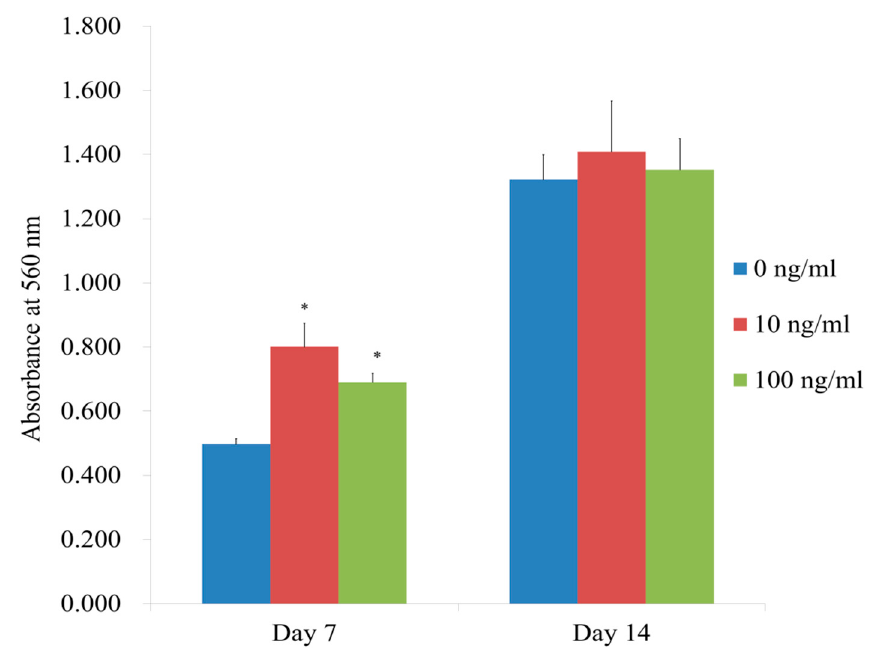
Figure 6. Results of Alizarin Red S staining on Days 7 and 14. * Significant differences were seen when compared to the control at Day 7 ( p < 0.05).